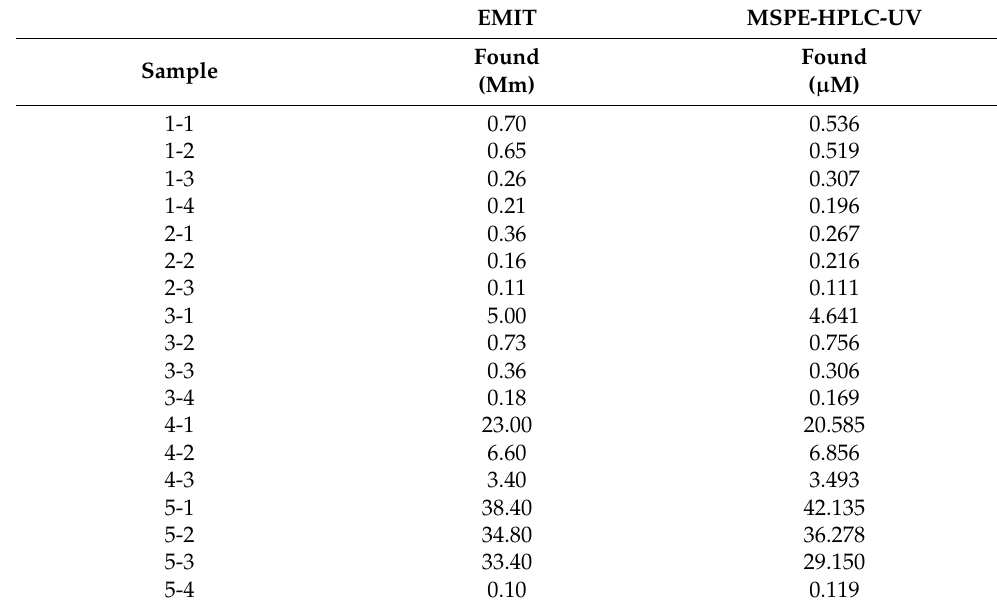
Table 4. Comparison of the MTX concentration in the plasma between EMIT and MSPE–HPLC–UV.